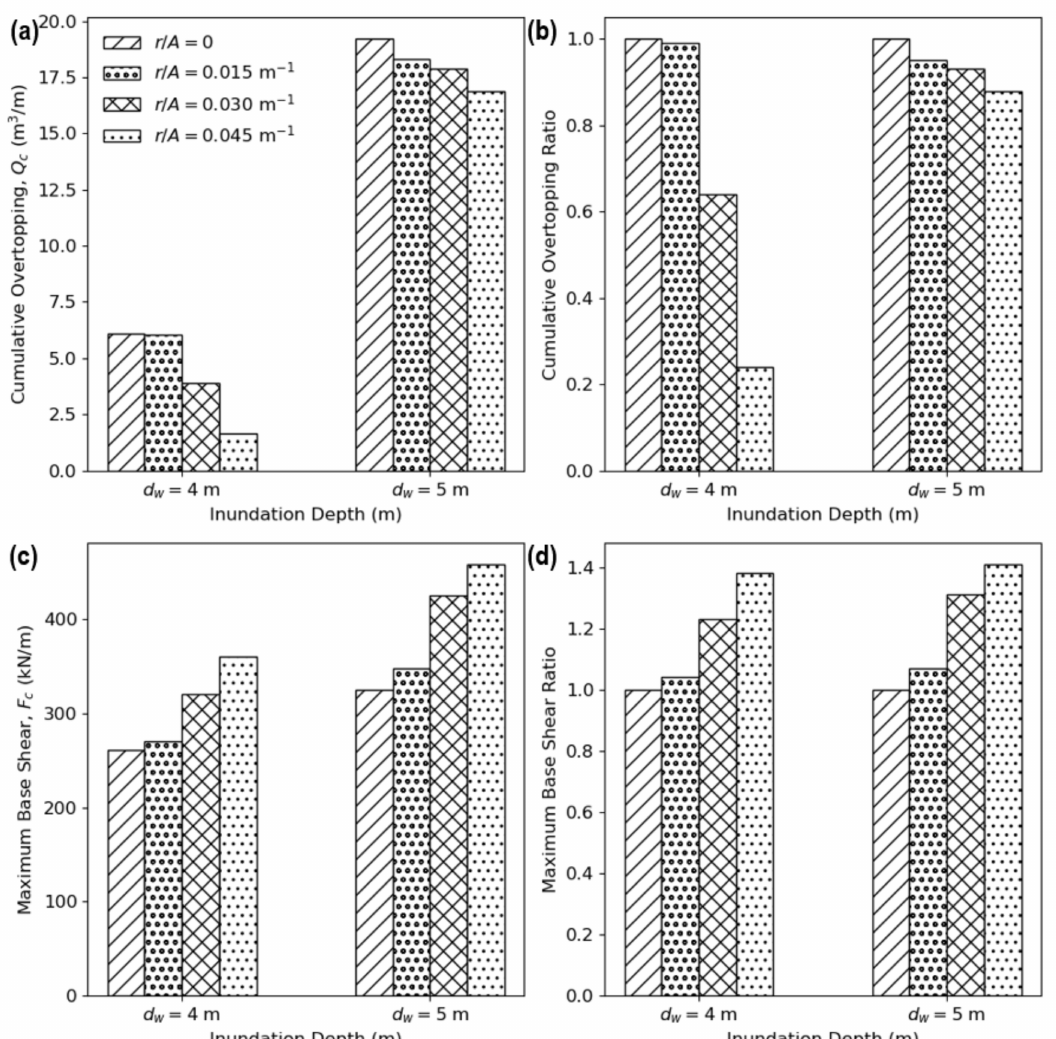
Figure 13. ( a ) Cumulative overtopping with ( b ) overtopping ratio relative to r / A = 0 and ( c ) maximum horizontal base shear with ( d ) maximum base shear ratio relative to r / A = 0 for various r / A and d w